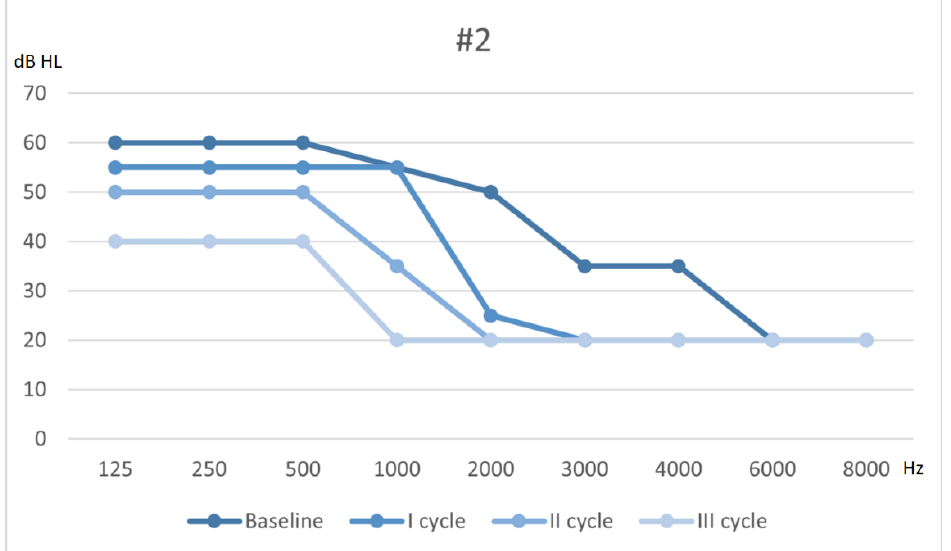
Figure 2. Hearing threshold from baseline to outcome (after 3 cycles of